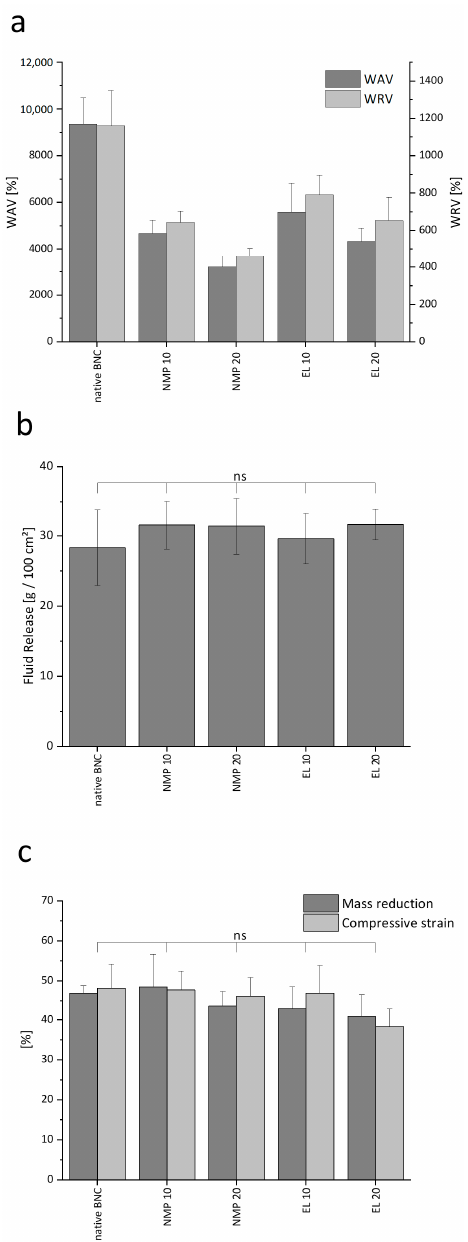
Figure 5. Comparison of the physicochemical characteristics of native BNC and PLGA loaded fleeces with ( a ) WAV and WRV, ( b ) fluid release, and ( c ) compression stability (mean ± SD of six different fleeces from two independent experiments, ns marks non-significant differences compared to native BNC with p > 0.05).